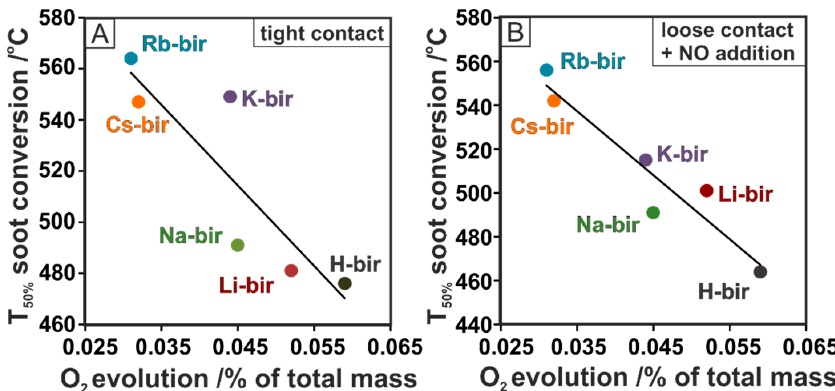
Figure 8. Experimental correlation of the T 50% of soot conversion and O 2 evolution in tight contact ( A ) and loose contact + NO ( B ) for birnessite containing various bulk alkali cations.